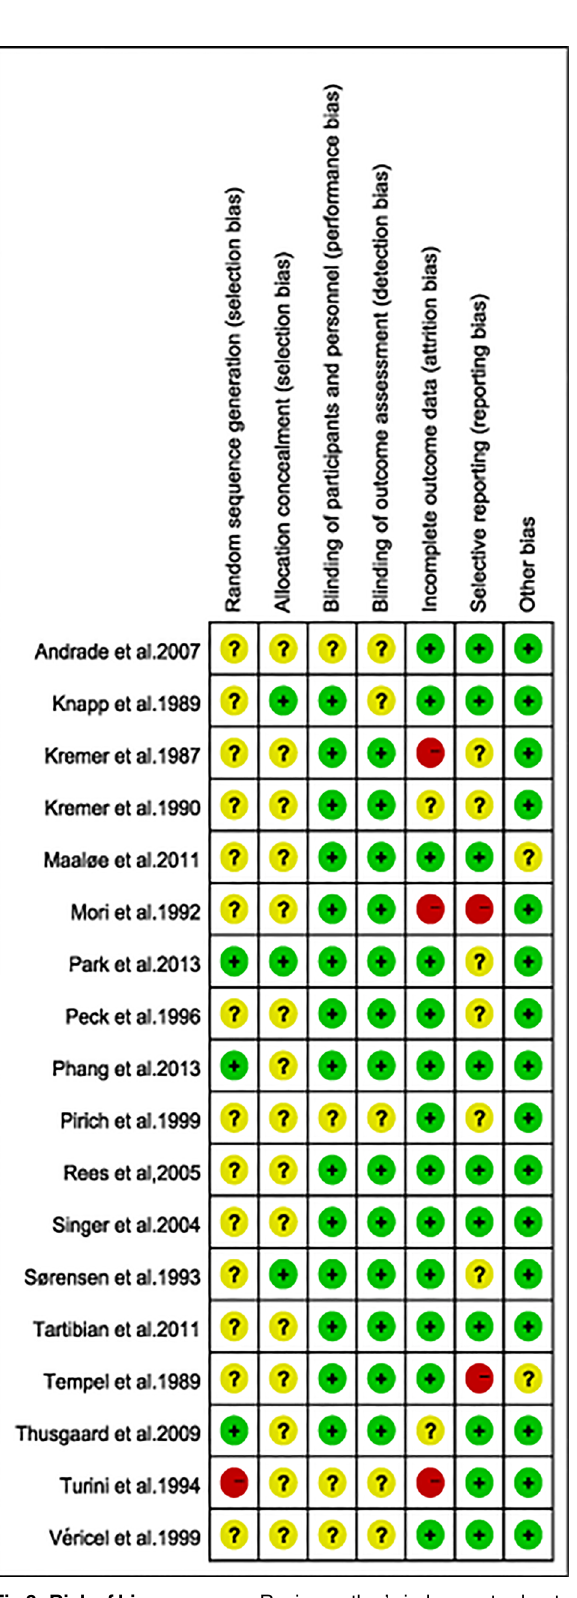
Fig 3. Risk of bias summary. Review author ’ s judgements about each risk of bias item for each included study. doi:10.1371/journal.pone.0147351.g003 PLOS ONE | DOI:10.1371/journal.pone.0147351 January 25,